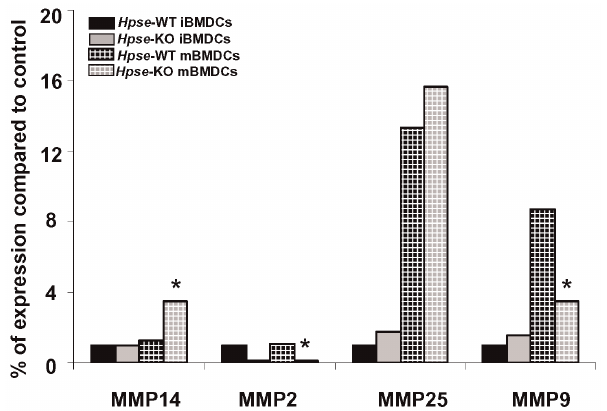
Figure 6. MMP expression. RT-PCR of MMPs in iBMDCs (black), and mBMDCs (grilled black), from Hpse- WT or in iBMDCs (gray), mBMDCs (grilled gray), from Hpse -KO mice. Maturation of BMDC was achieved with a cocktail of 30 ng/ml recombinant mTNF a and 1 m g/ml PGE2 for 24 hrs. RNA was extracted from iBMDCs and mBMDCs from Hpse- WT and Hpse -KO mice. Primers specific for MMP-2, MMP-9, MMP-25, and MMP-14 were used for RT-PCR (see Methods). Asterisk indicates p , 0.02, t-test.